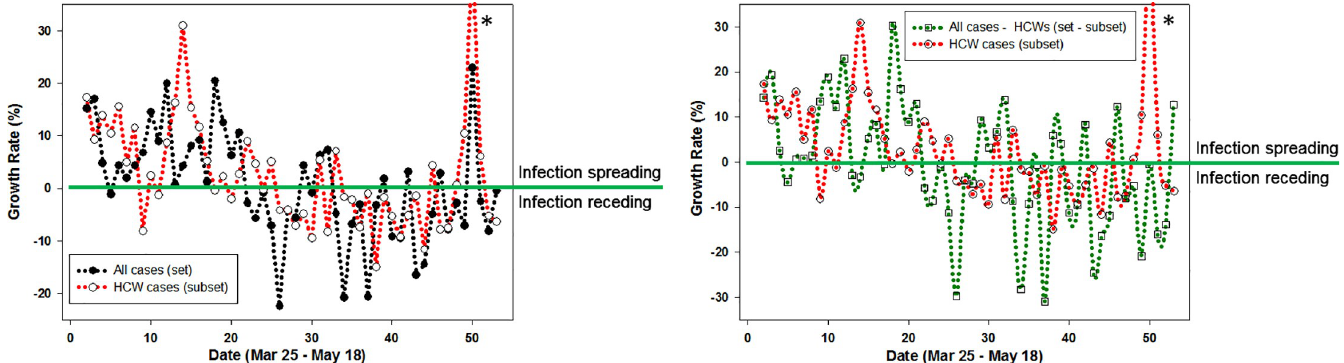
Fig 7. Left: Plot of the five-day moving average growth rate for all population (set, black trace) versus HCWs (subset, red trace) for Mar 25—May 18. Right: Plot of the growth rate of all population minus HCWs (set–subset, green trace) versus HCWs (subset, red trace) for Mar 25—May 18 in Ireland. � Reference [18].